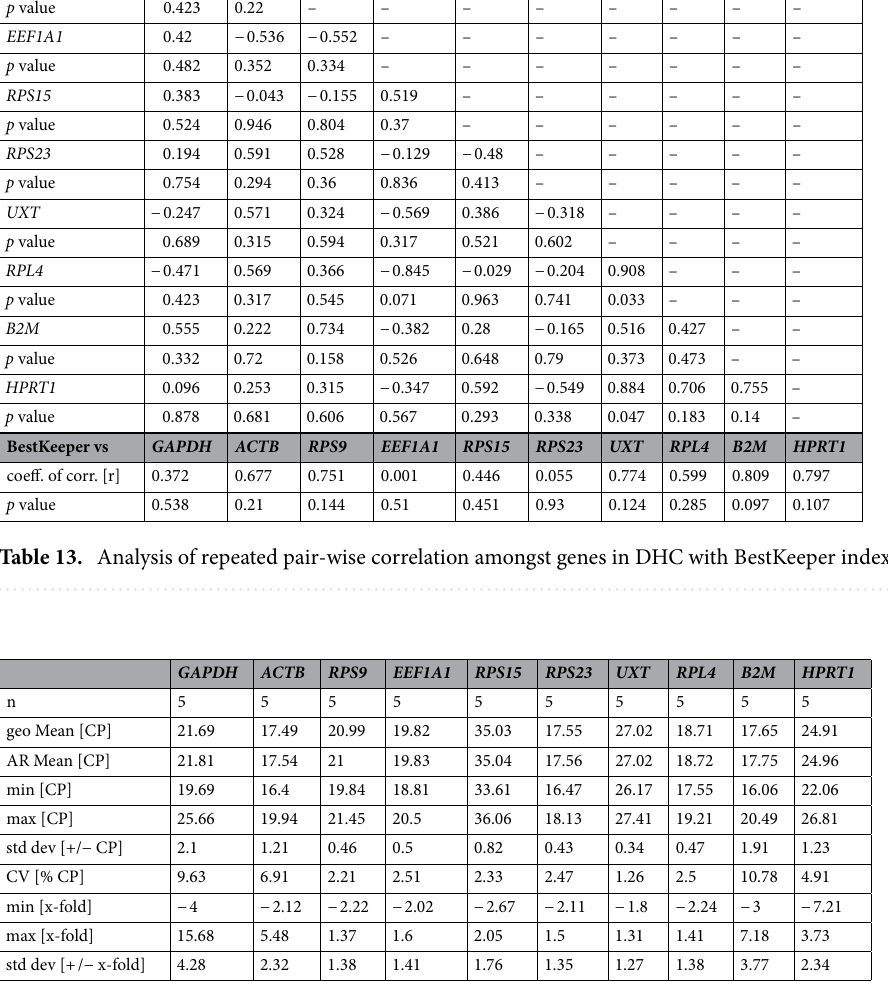
Table 14. Analysis of parameters based quantitative cycling points (CP) for 10 candidate RGs in